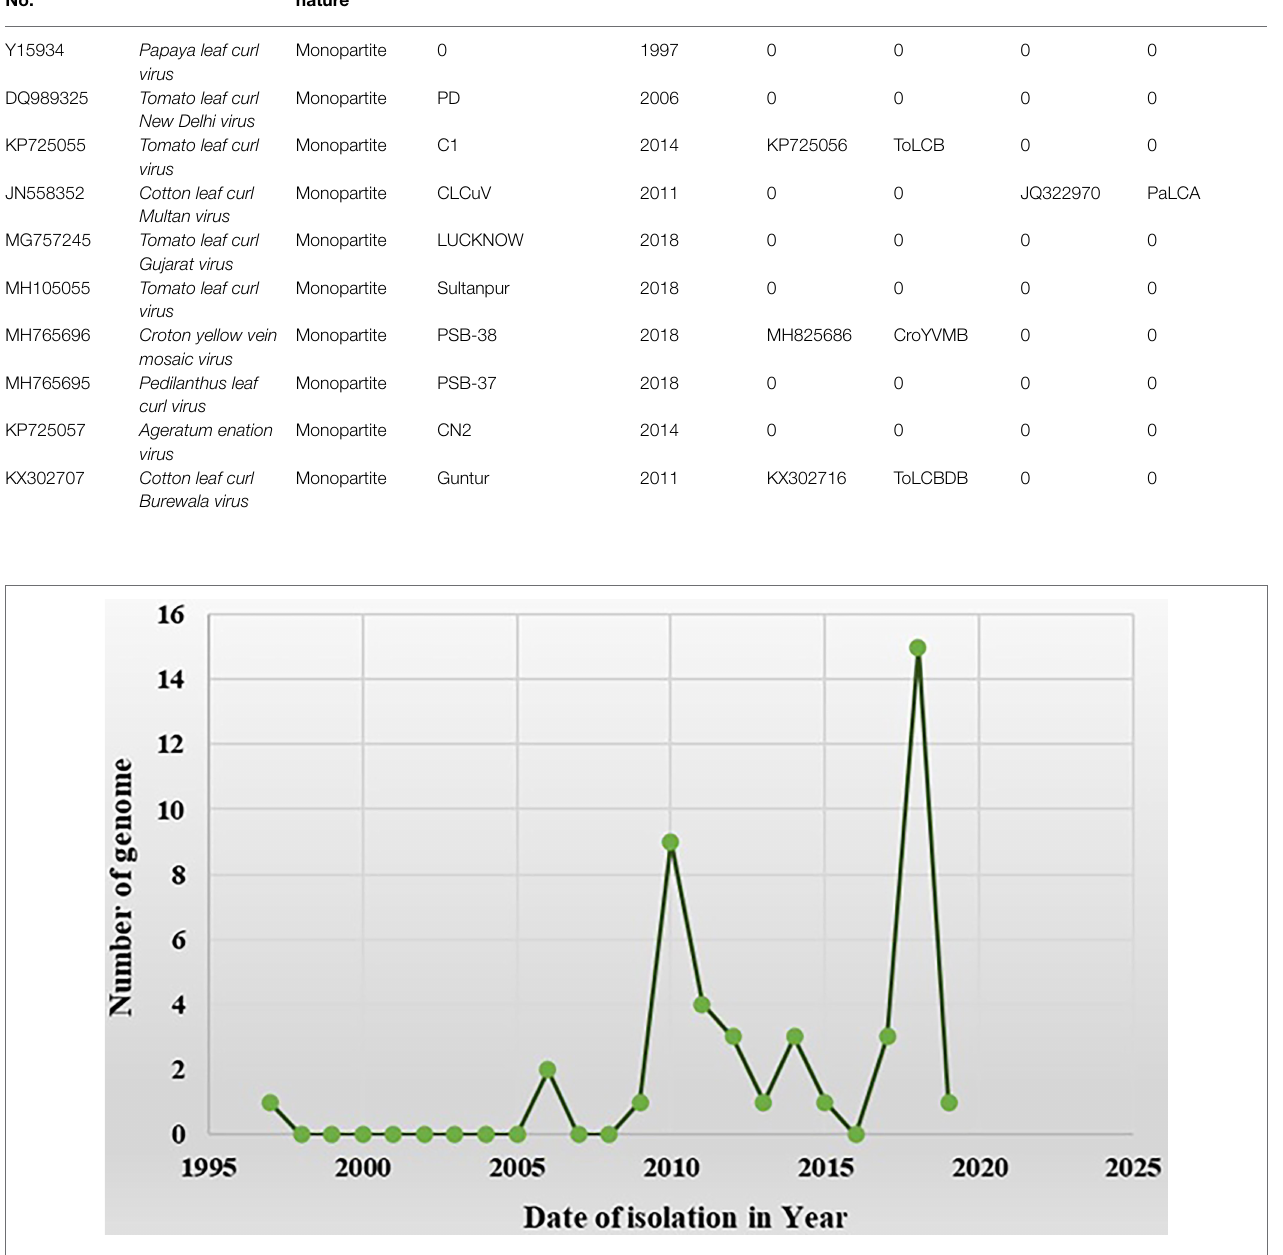
FIGURE 5 | A time-curve graph depicting the distribution of 44 begomovirus genomes in India by date of isolation. The numbers of complete genomes of begomovirus were plotted against the time of their collection from the year 1997 to the year 2021 (data from